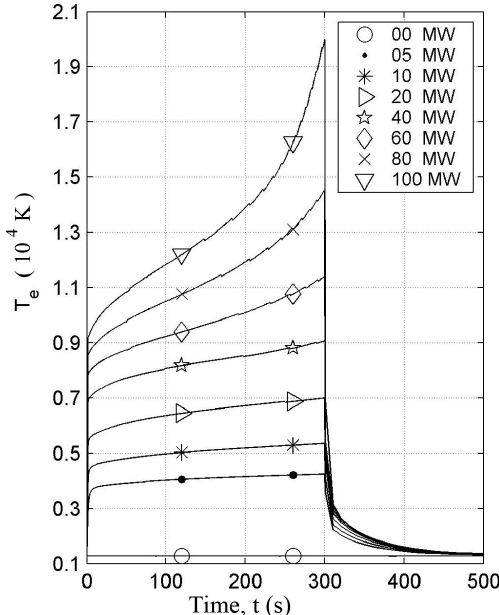
Fig. 3. The time variations of the electron temperature (in units of 10 4 K) at the level h = 300km. The results are given for different values of the EAP: 5, 10, 20, 40, 60, 80, and 100MW, with sym- bol 0MW indicating the results obtained under natural conditions without heating.